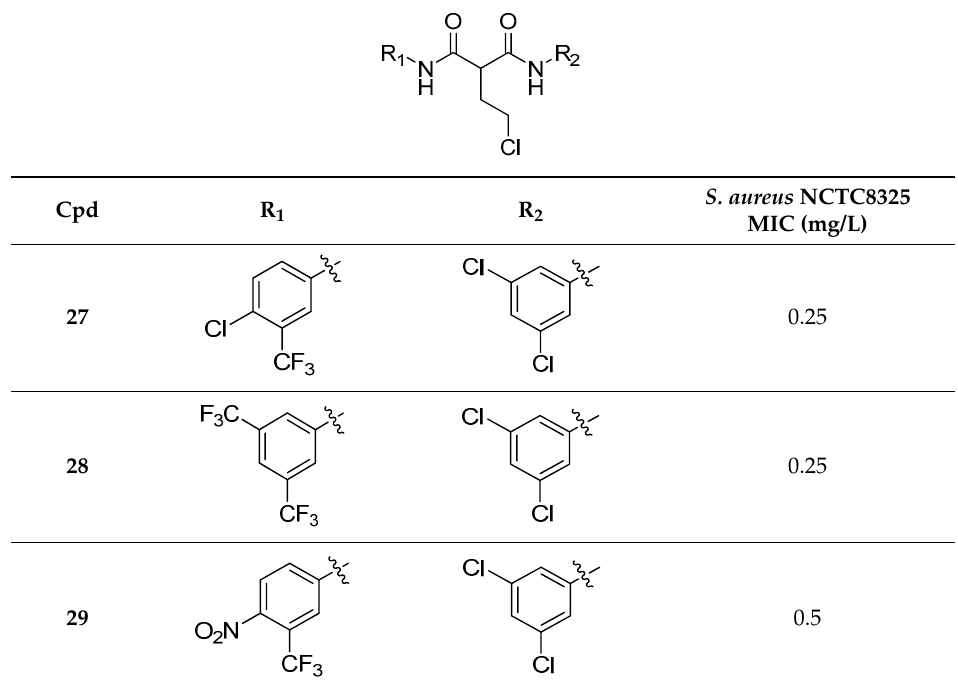
Table 2. Antibacterial activity of asymmetric ethyl chloride malonate derivatives against S. aureus NCTC8325.